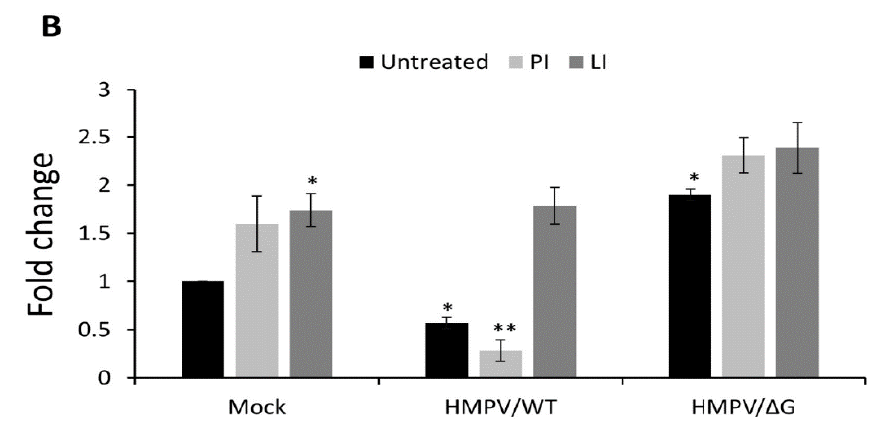
Figure 4. UL16 binding protein-2 (ULBP2) total expression following HMPV infection. ( A ) Western Blot analysis of ULPB2 (28 kDa) expression in mock-infected A549 cells (Mock), HMPV / WT-infected A549 cells (HMPV / WT), and HMPV / ∆ G-infected A549 cells (HMPV / ∆ G) with or without treatment with proteasome and lysosome inhibitors (PI, LI, respectively) (upper panel). Vinculin was used as a